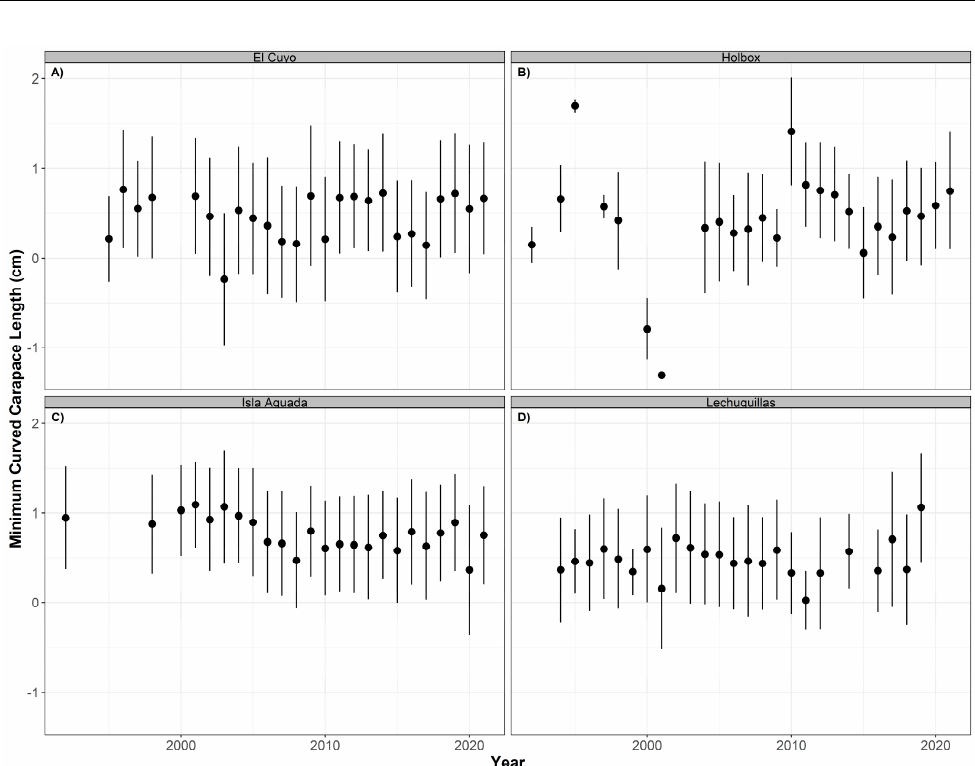
Figure 4. Time series of minimum curved carapace length (annual mean ± SD) for hawksbill turtles ( Eretmochelys imbricata ) nesting at Celestún ( A ), El Cuyo ( B ), Holbox ( C ), and Isla Aguada ( D ) from 1990 to 2021.